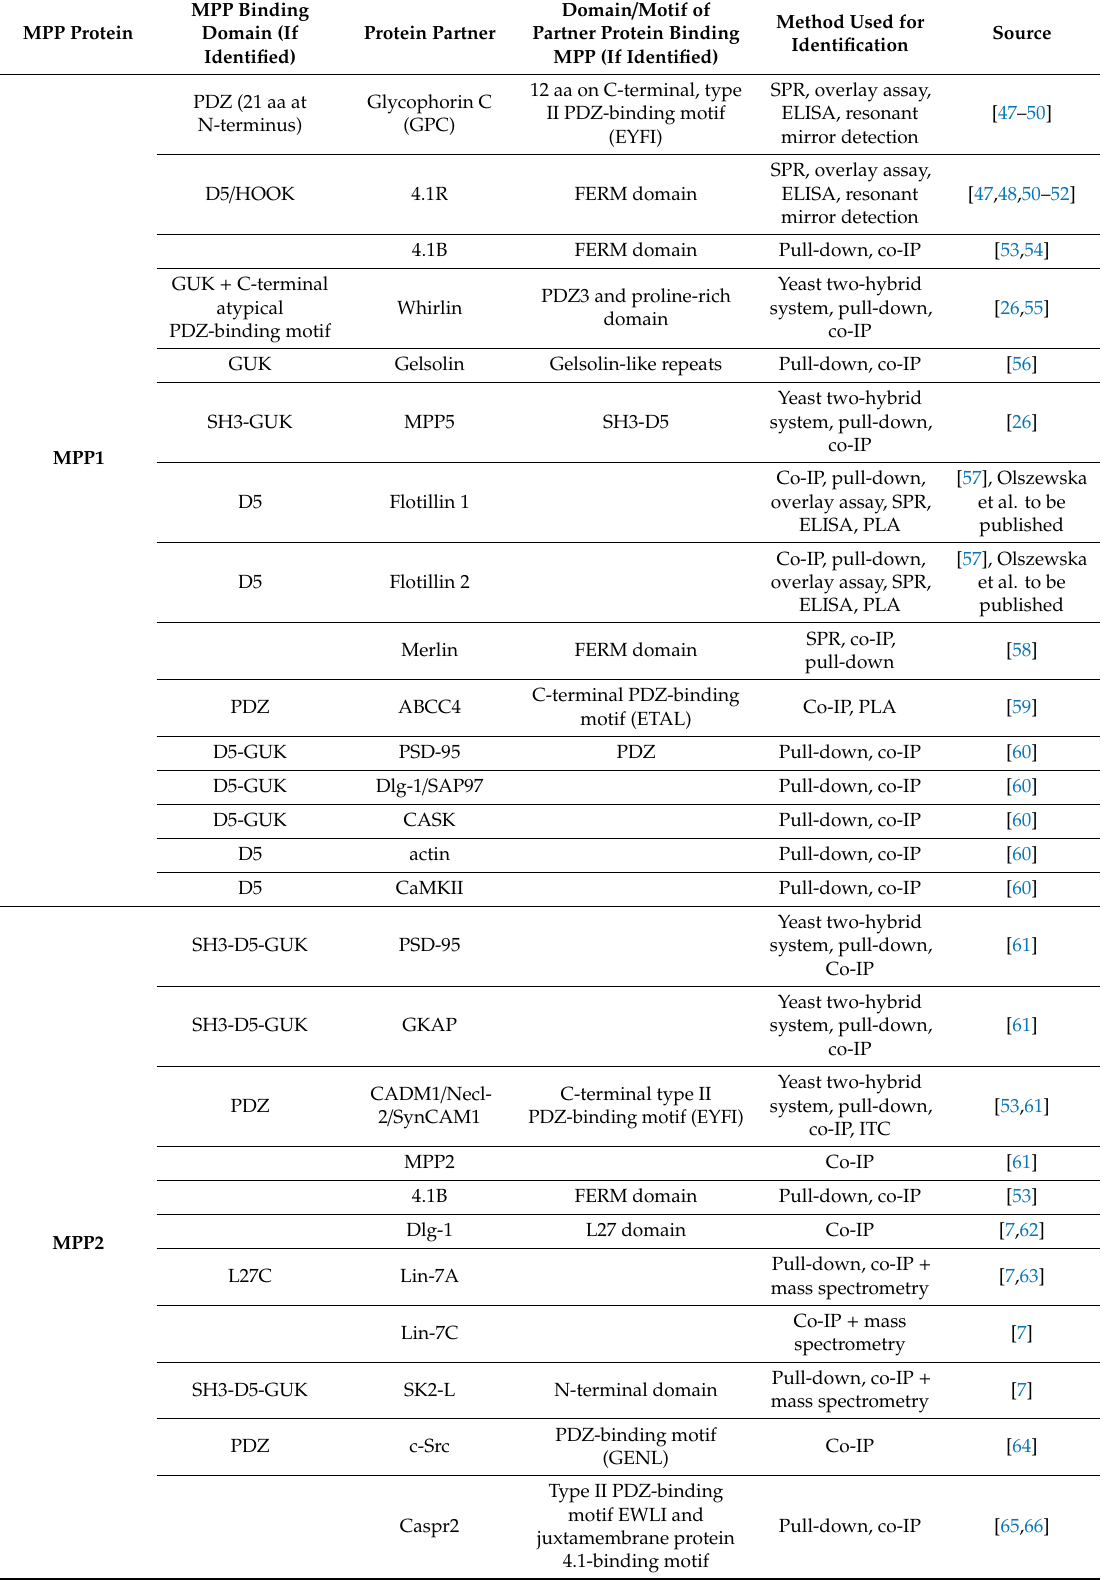
Table 1. List of MPP protein